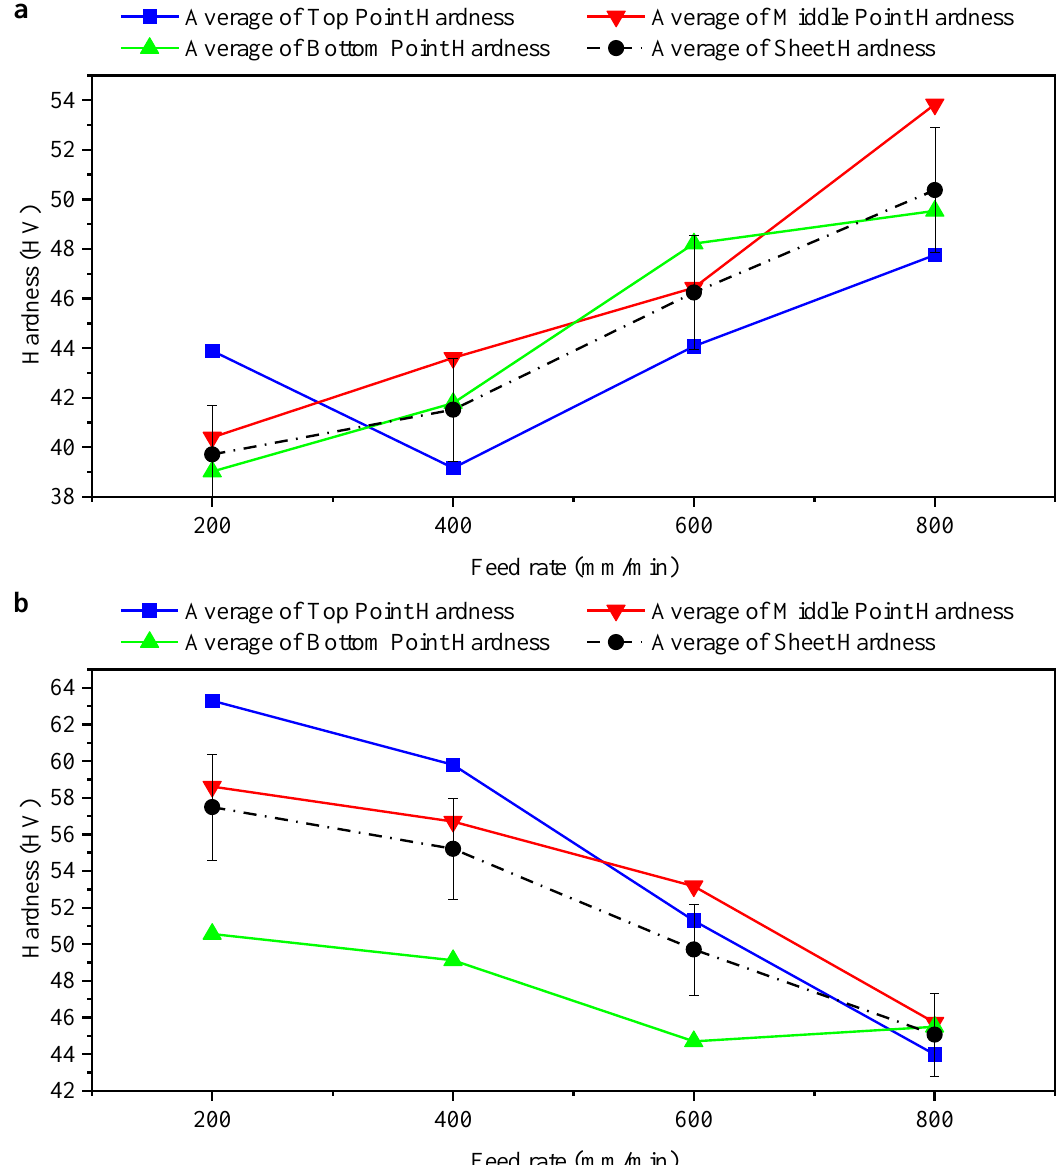
Figure 6. ( a ) Effects of different feed rates on hardness of formed sheet when using coolant oil, ( b ) effects of varied feed rates on hardness of formed sheet when using grease.